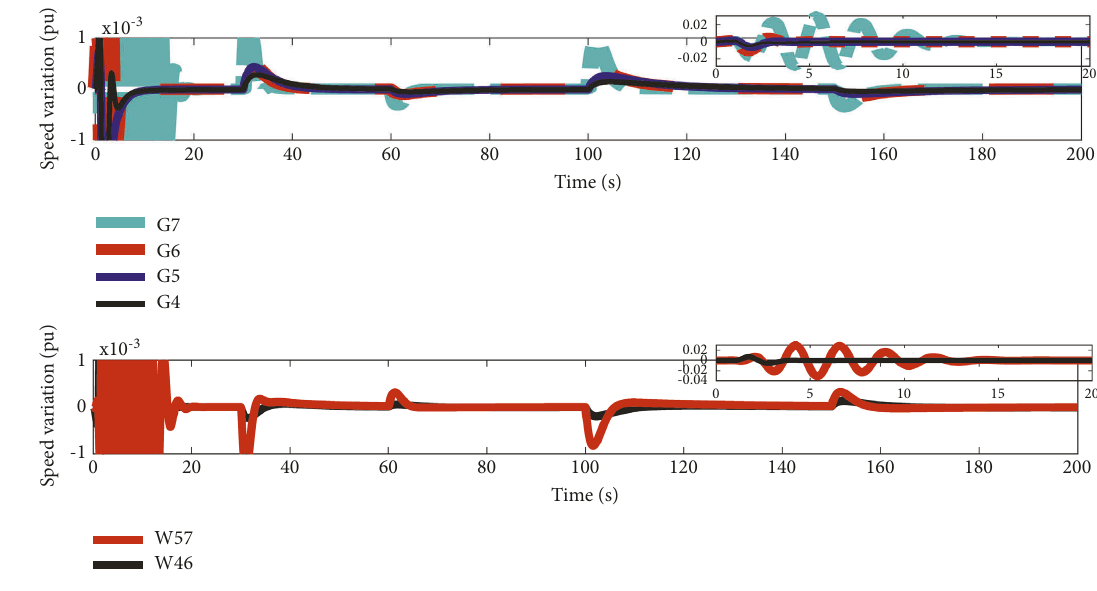
Figure 23: Angular frequency variation of G